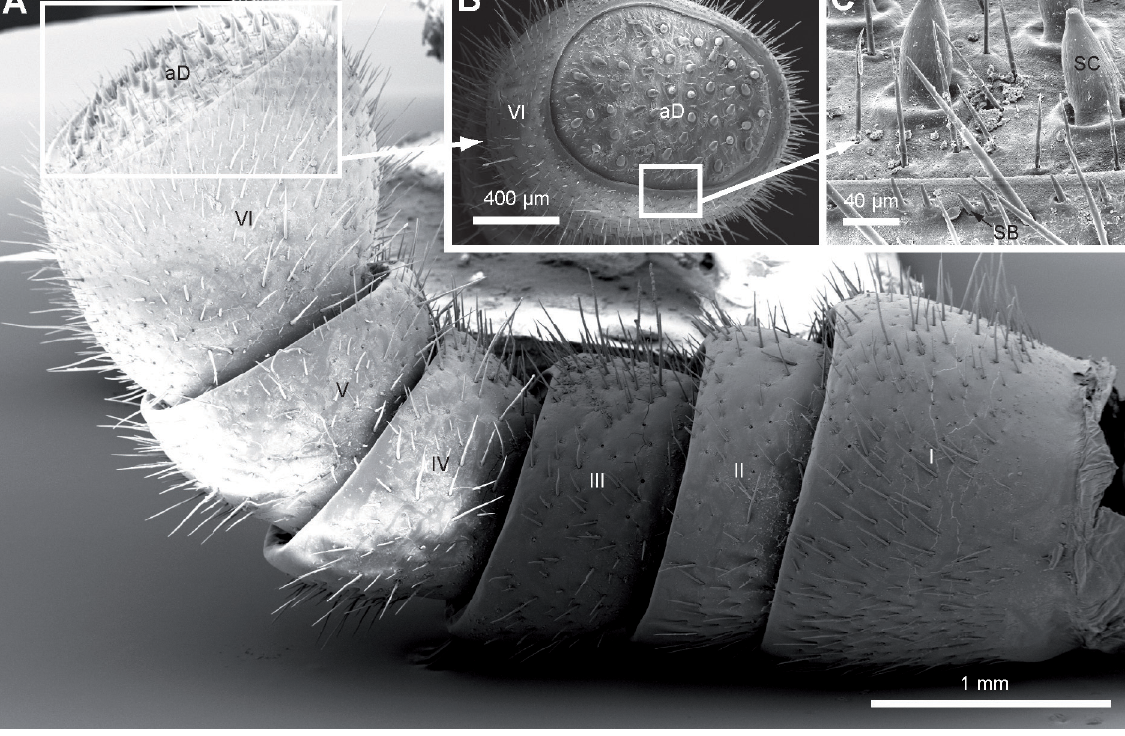
Fig. 7. Sphaeromimus midongy sp. nov., SEM of left antenna, ♂, holotype ( FMNH-INS 3119888). A . Overview. B . Detail of antennal disc. C . Detail of margin of antennal disc. Abbreviations: aD